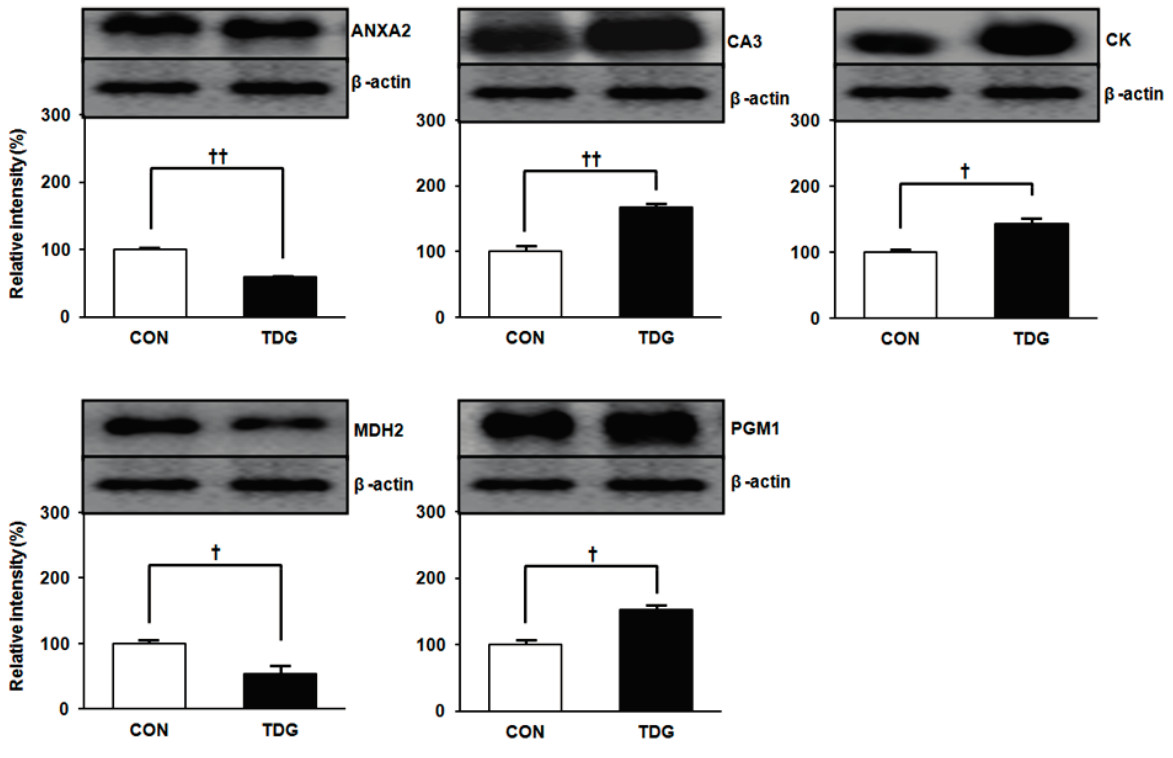
Figure 5. Validation of proteomic data by immunoblot analysis. Five proteins identified